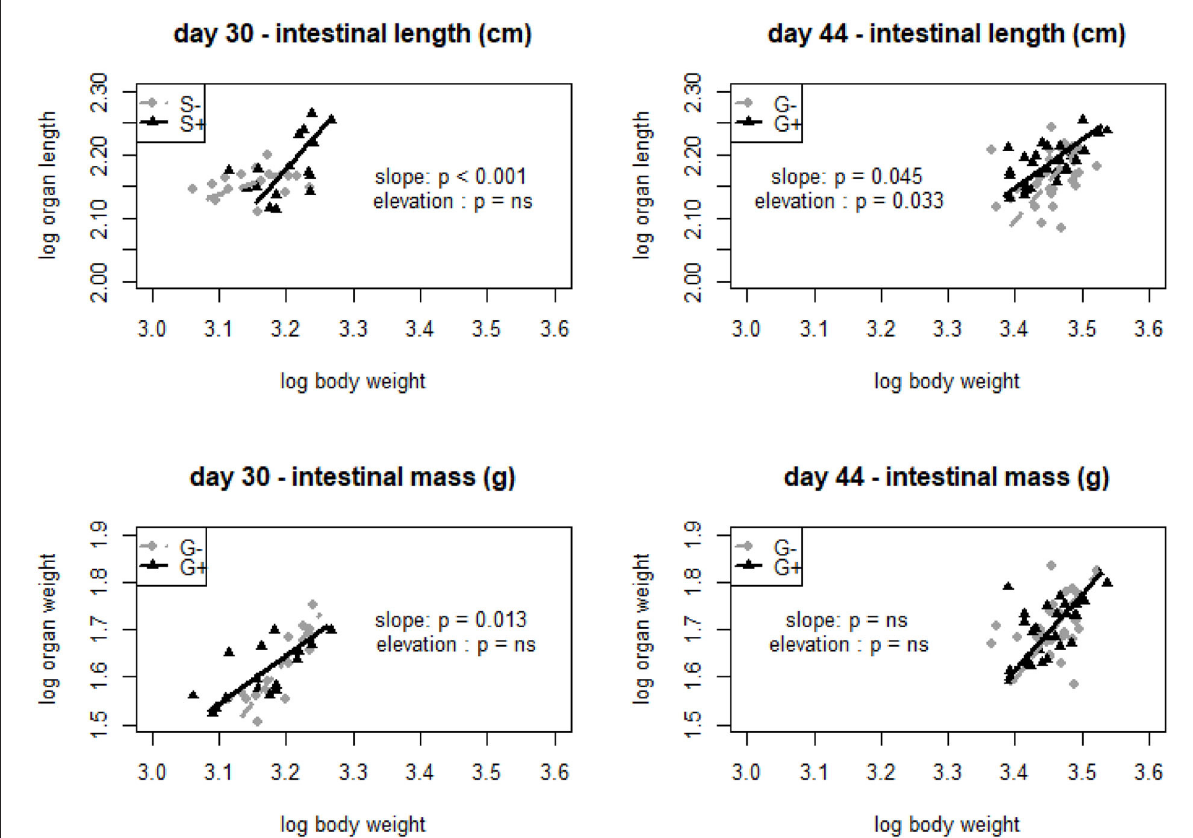
FIGURE2 Standardized major axis log-log relationships of intestinal length (cm) and intestinal mass (g) with body weight at day 30 with starter main effect (S) with no tannins (–) represented by diamonds and starter (S) with tannins ( + ) represented with triangles. At day 44, grower main effect (G) is represented by diamonds in groups that received no tannins (–) and triangles that received tannins ( + ).